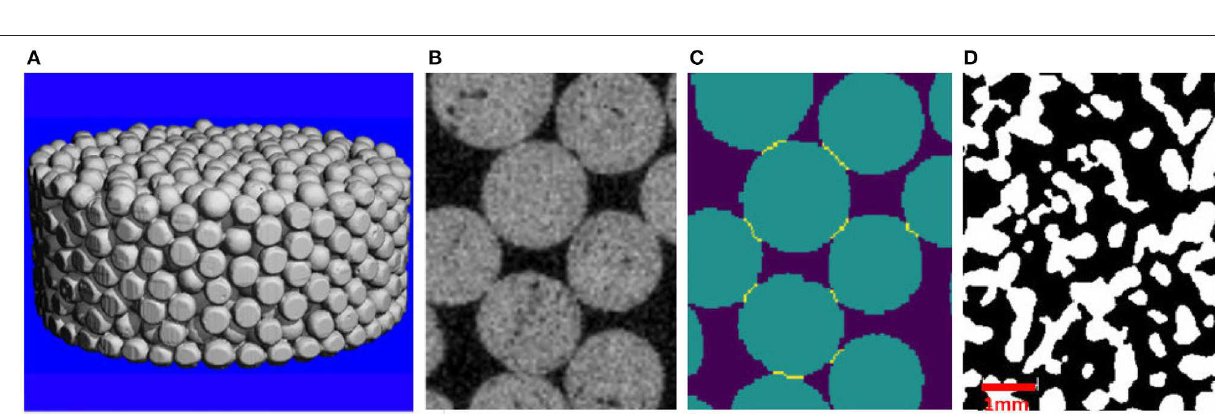
FIGURE 3 | CT images of the samples: (A) binary 3D image of experimental cylindrical ice bead sample (the particles at the rim appear flat, due to the chosen section, to cut out the sample holder wall). (B) 2D slice of ice bead sample, gray image with 18 µ m resolution; (C) downscaled and segmented binary image, ice beads were identified using a watershed algorithm and the watersheds as contacts between the particles are depicted as yellow lines. (D) Binary microstructure of nature identical snow (white ice phase), identification of particles and contacts is ambiguous. fixed cylinder wall determined the sample height of 14